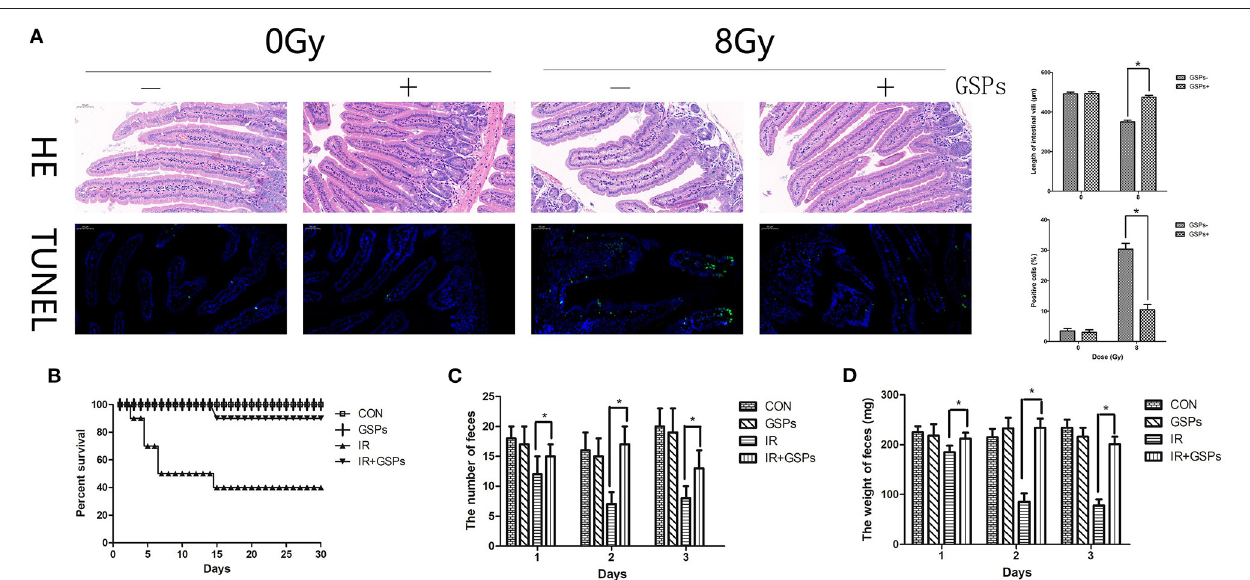
FIGURE 4 | Grape seed proanthocyanidins have radioprotective effects on the intestines. (A) HE and TUNEL staining of the jejunum dissected 5 days after 8Gy local abdominal IR. Quantitative analysis results show that the small intestinal villus is shortened induced by IR, with apoptosis of a large number of intestinal epithelial cells, while GSPs alleviate these injuries. (B) The 30-day survival rate of the IR group is 40% after 27Gy abdominal local IR, while the 30-day survival rate of the IR + GSPs group is 90%. The quantity (C) and weight (D) of the feces in the first 3 days after 27Gy IR are significantly reduced, while GSPs treatment alleviate these changes. Data are presented as mean ± SD ( n = 10, Figure 5B ; n = 6, Figures 5C,D ). * P <